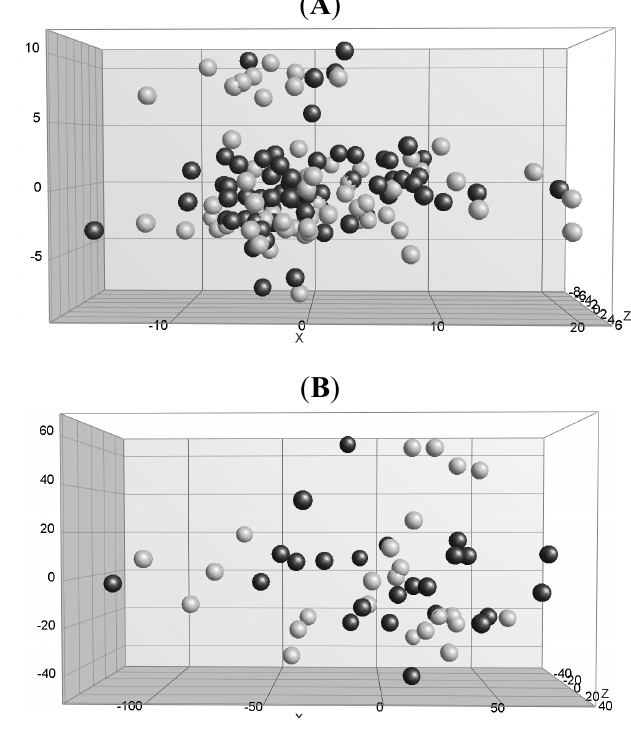
Figure 1. Principal component analysis (PCA) 3D view for protein profiles. Legend: ( A ) for 68 cases (black dots) and 68 controls (gray dots) and ( B ) for the subset consisting of 24 cases and 24 controls. The PCA in both A and B is based on all ten proteins. The first three components are